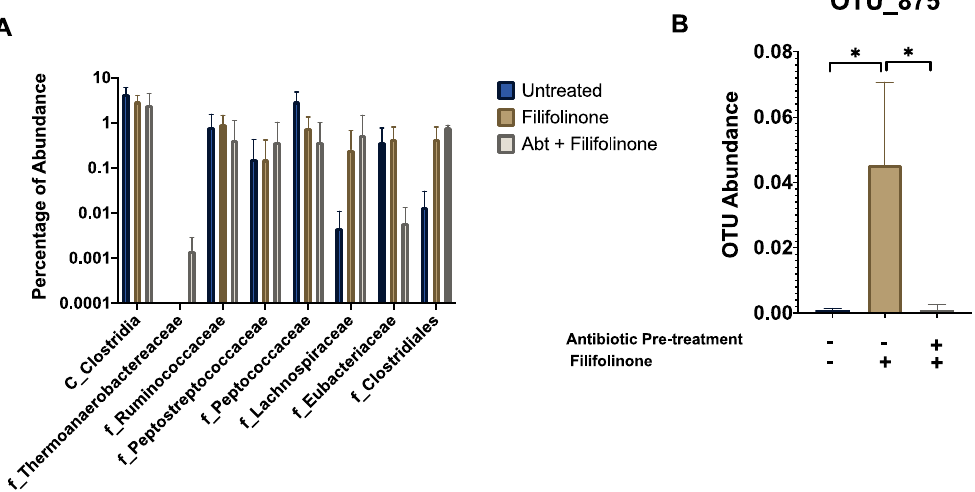
Figure 11. Effect of filifolinone on Class Clostridia. The figure shows ( A ) the relative abundance of the families from the Class Clostridia associated with the production of butyrate in fish pre-treated with antibiotics and stimulated with filifolinone (Abt+ filifolinone), treated with filifolinone, and without treatment (untreated); and ( B ) the abundance (percentage) of OTU_875 (Coprothermobacter spp.) in fish treated with filifolinone, pre-treated with antibiotics and controls (untreated). Statistical significance was determined by a t -test with p < 0.05 (*).